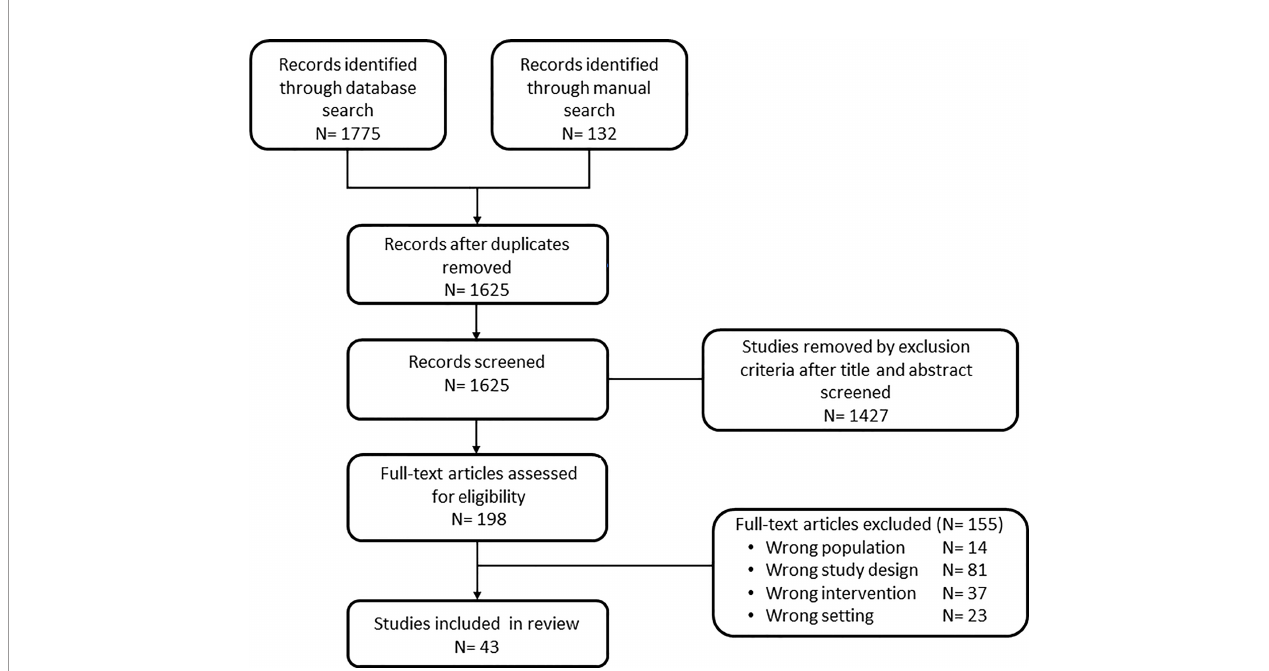
FIGURE 1 | Flowchart of systematic literature search process. N is abbreviation for